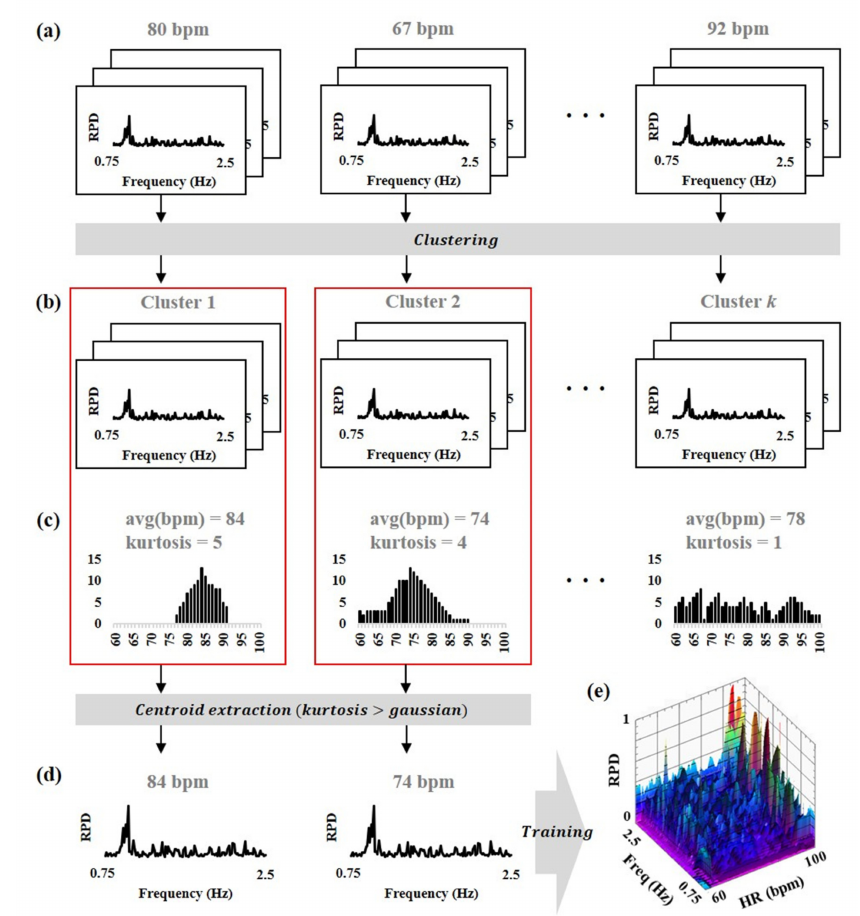
Figure 3. Overview of training model using the unsupervised clustering. ( a ) Dataset consisting of RPD (i.e., features) and heart rate (i.e., labels), ( b ) unsupervised clustering with k clusters, ( c ) kurtosis of distribution calculated from each cluster, ( d ) centroid extraction of each cluster with higher kurtosis than gaussian, ( e ) trained model consisting of RPD and heart